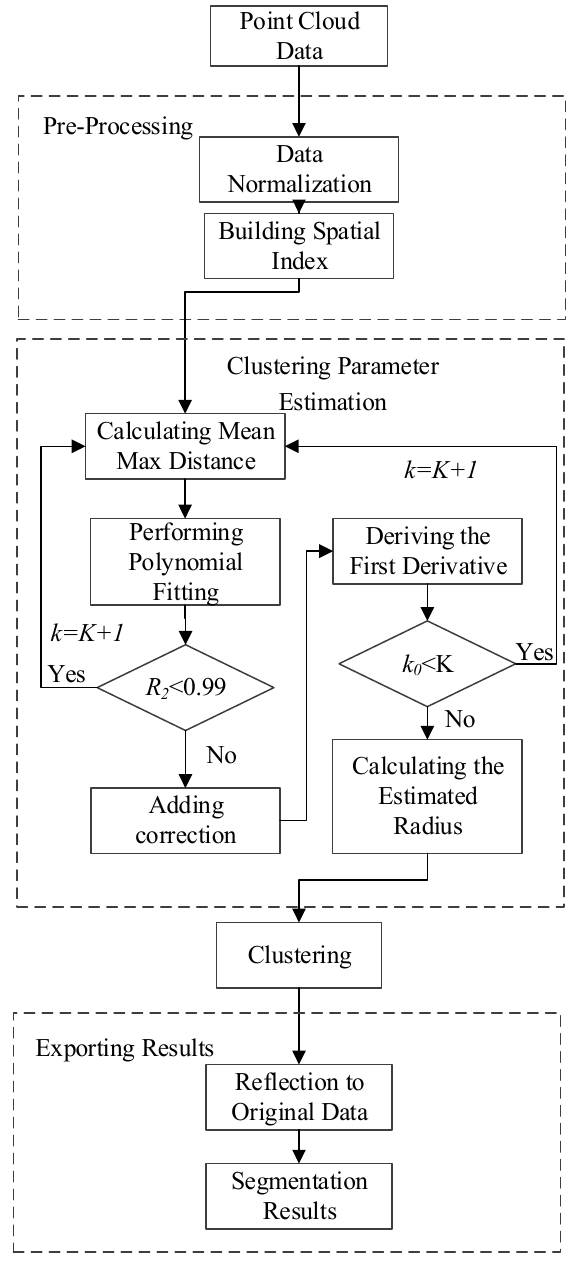
Figure 1. Segmentation workflow.